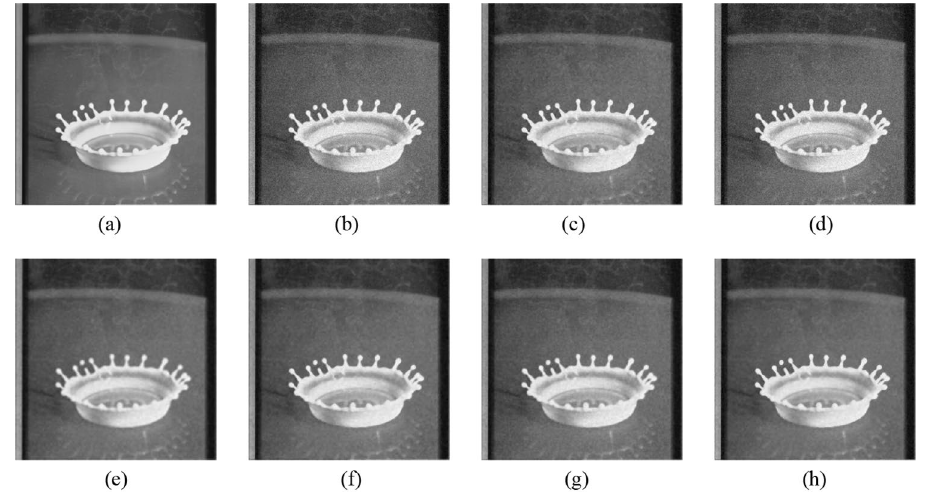
Figure 18. Comparison of denoising performance of each filter against the Gaussian noise (“Milkdrop”). ( a ) Original image; ( b ) noise-added image; ( c ) filtered image using abwFMGFI; ( d ) filtered image using NLMF (templateWindowSize: 21, searchWindowSize: 7); ( e ) filtered image using GF (σ_x: 5, σ_y: 5); ( f ) filtered image using MF; ( g ) filtered image using BF (σ_c: 35, σ_s: 5); ( h ) filtered image using ABF (σ_s: 7, max_σ_c: